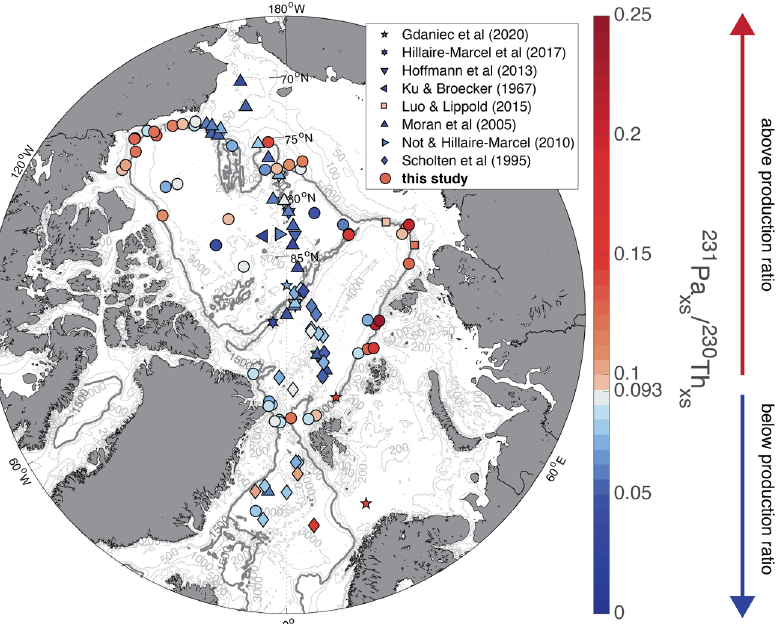
Fig. 2 Excess protactinium-231/thorium-230 activity ratios in bulk surface sediments. Symbol shape indicates the data source; new data provided by this study are shown in circles. Orange and red symbols indicate 231 Pa/ 230 Th ratios above the production ratio (0.093), blue symbols indicate 231 Pa/ 230 Th ratios below the production ratio. The 1500 m isobath is shown in bold.